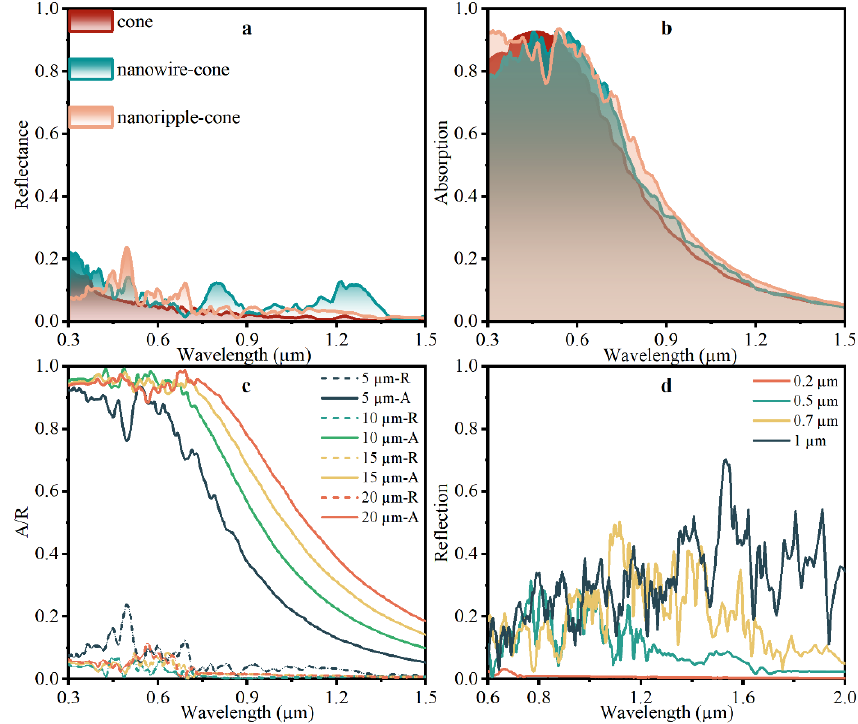
Figure 7. ( a ) Reflectance curves and ( b ) absorption spectra of structures (cone alone, nanowire-cone and nanoripple-cone), as shown in Figure 6. Additionally, optical responses for nanoripple-cone ( c ) with different micro-scale cones and ( d ) with different nano-scale ripples.